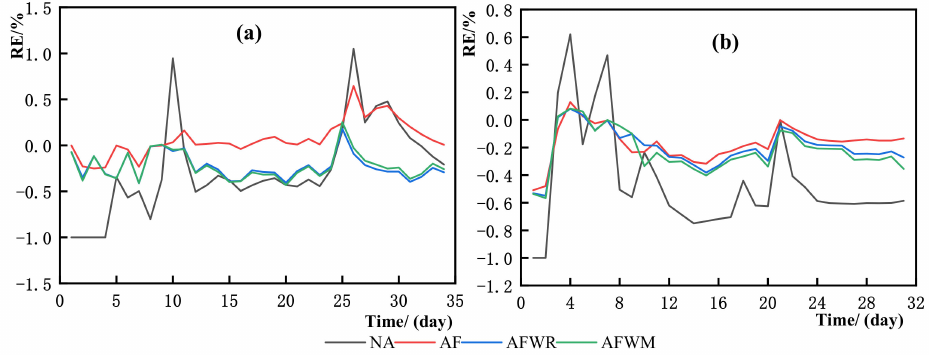
Figure 10. RE values under the four assimilation settings for medium floods for the two stations: ( a ) Gubeikou; ( b )